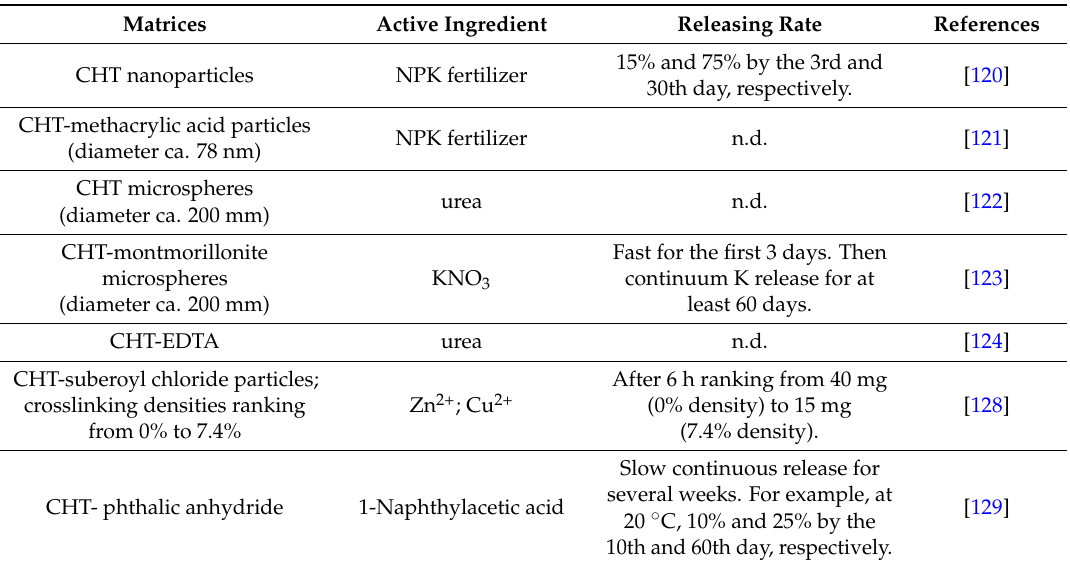
Table 2. Examples of fertilizers and micronutrients encapsulated in CHT-based controlled release matrix. Matrices Active